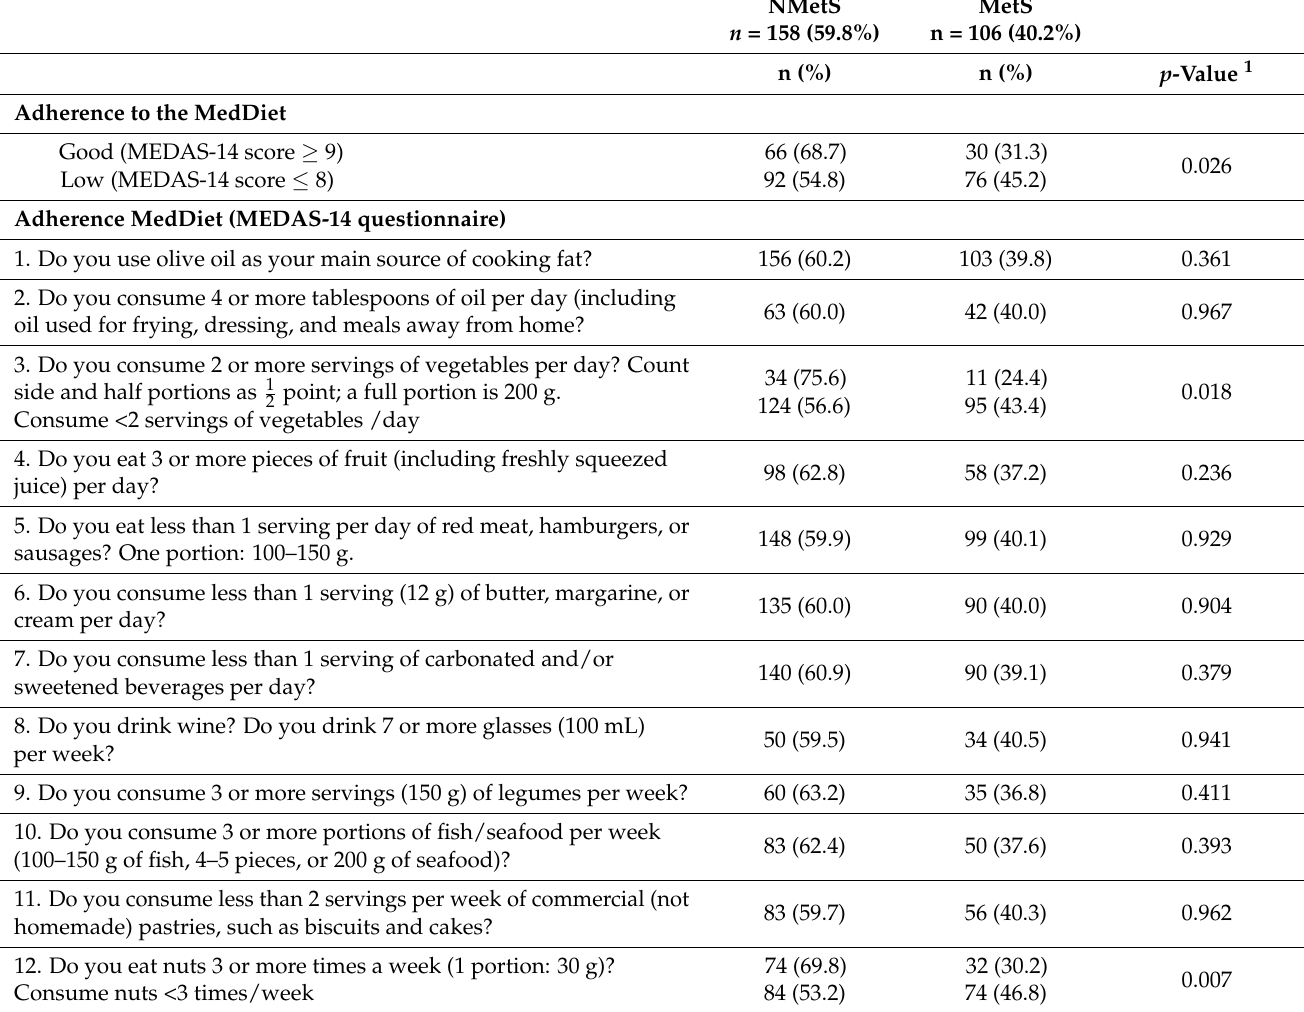
Table 1. Adherence to the Mediterranean diet and the components of the MEDAS-14 questionnaire according to the prevalence of metabolic syndrome.